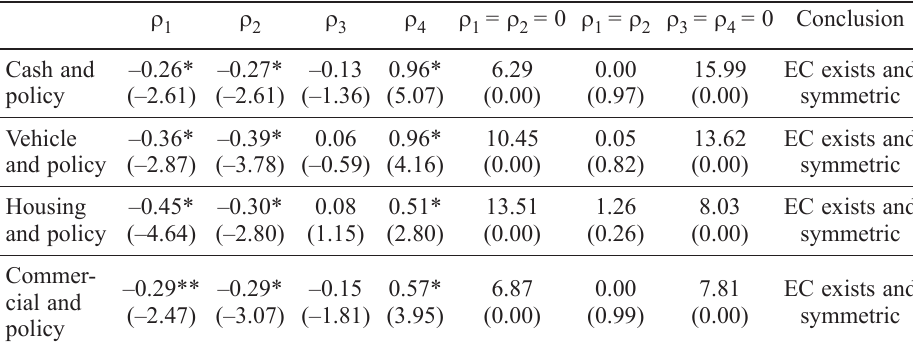
Table 7. Coefficients of EC models – MTAR specification ( τ =